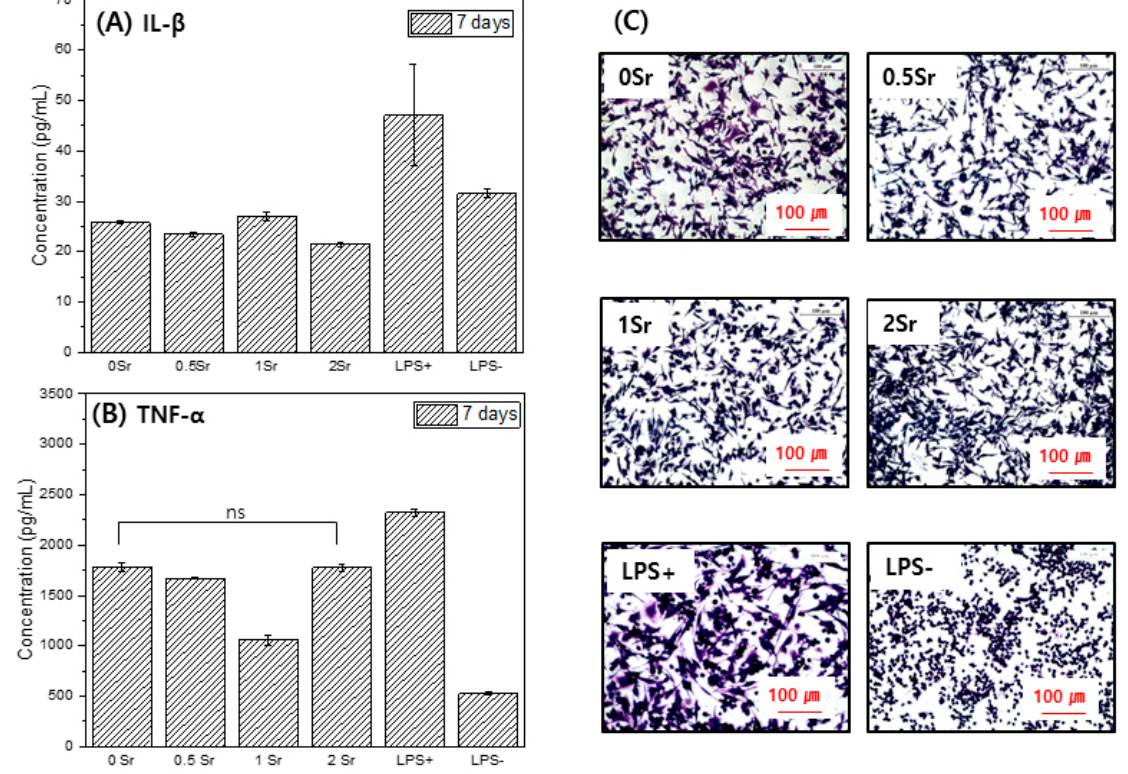
Figure 6. IL-1( A ), TNF- α ( B ), and cell morphology ( C ) for Raw 264.7 cells cultured, in the extracted media for 7 days (ns, no statistical significance).